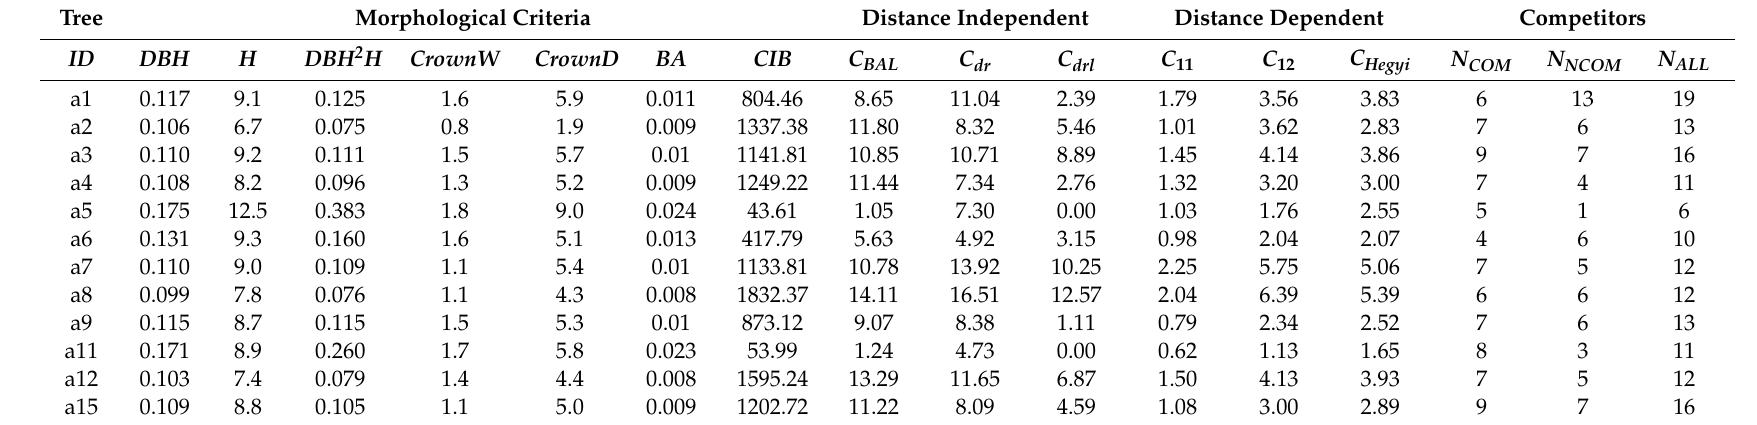
Table 1. Sample trees variables: morphological criteria, competition indices, and number of close